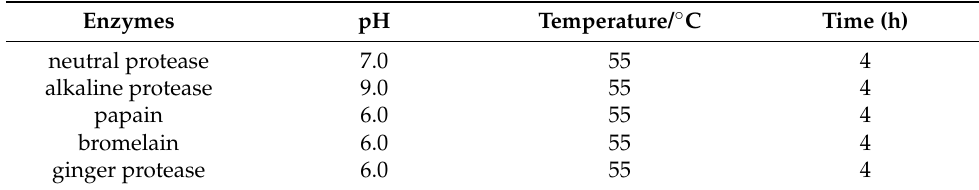
Table 1. Hydrolysis